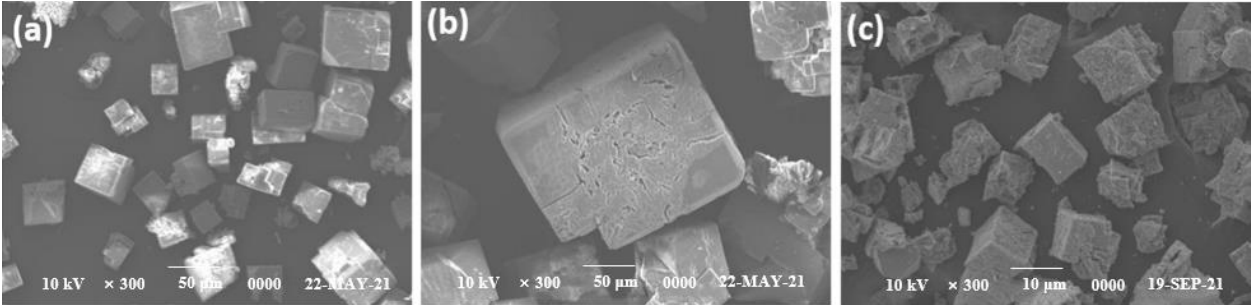
Figure 9. SEM of MOF-5 obtained with different organic ligands H 2 BDC ( a ), H 2 BDC(NH 2 ) ( b ), H 2 BDC(NO 2 ) ( c ).